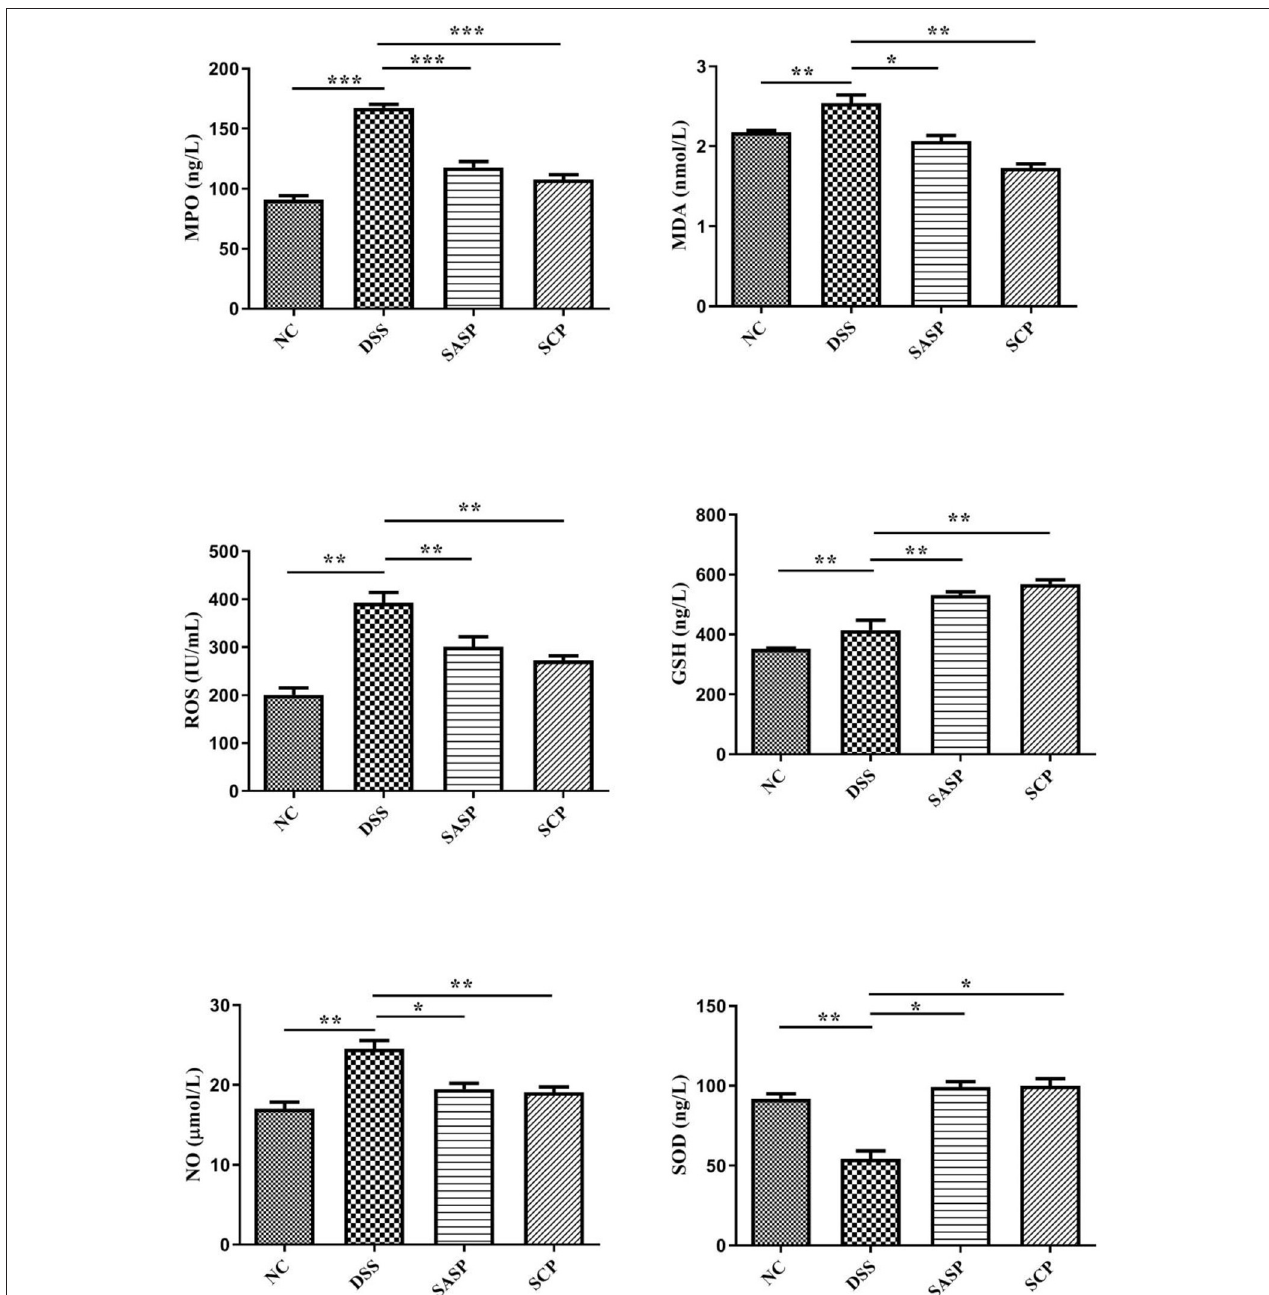
FIGURE 3 | Levels of inflammatory cytokines. NC, control group; M, DSS group; SASP, positive drug group; SCP, S. chinensis polysaccharide group. Data are expressed as means ± S.D. * p < 0.05, ** p < 0.01, *** p < 0.001.